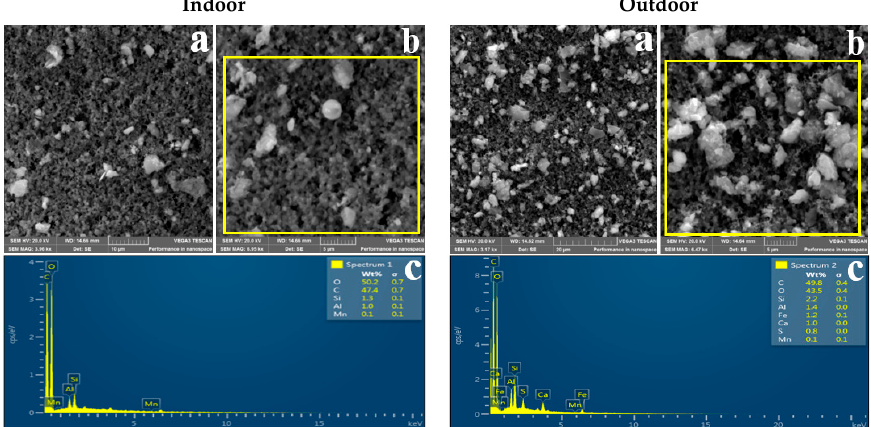
Figure 3. SEM images of indoor and outdoor PM 2.5 sampled at New Sicelo: ( a ) indoor image captured at 10 µm; ( b ) indoor captured at 5 µm; ( a ) outdoor image captured at 20 µm; ( b ) image captured at 5 µm; ( c ) EDS spectrum of the portion highlighted in yellow.